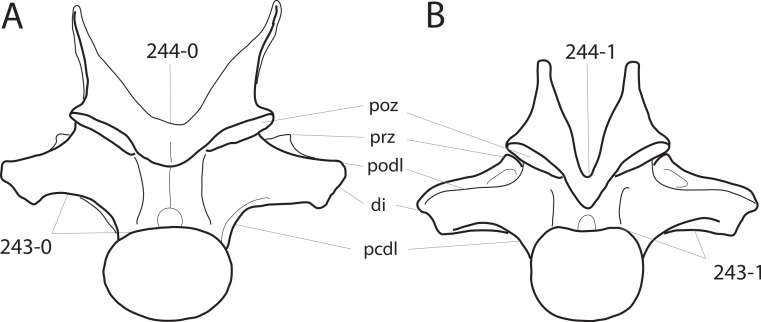
Dorsal vertebra 1 of apatosaurines.Dorsal vertebra 1 of Apatosaurus louisae CM 3018 (A) and Brontosaurus parvus UW 15556 (B; both traced from Gilmore, 1936) in posterior view. Note the different positions of the transverse processes (high, A, C243-0; low, B, C243-1), and the varying width of the base of the bifurcated spines (wide, A, C244-0; narrow, B, C244-1). Abb.: di, diapophysis; pcdl, posterior centrodiapophyseal lamina; podl, postzygodiapophyseal lamina; poz, postzygapophysis; prz, prezygapophysis. Scaled to same posterior cotyle height.